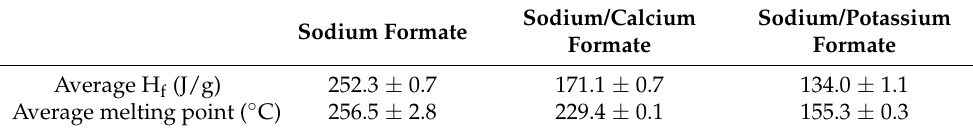
Table 1. Measured melting point and latent heat of fusion of three target formate PCMs.